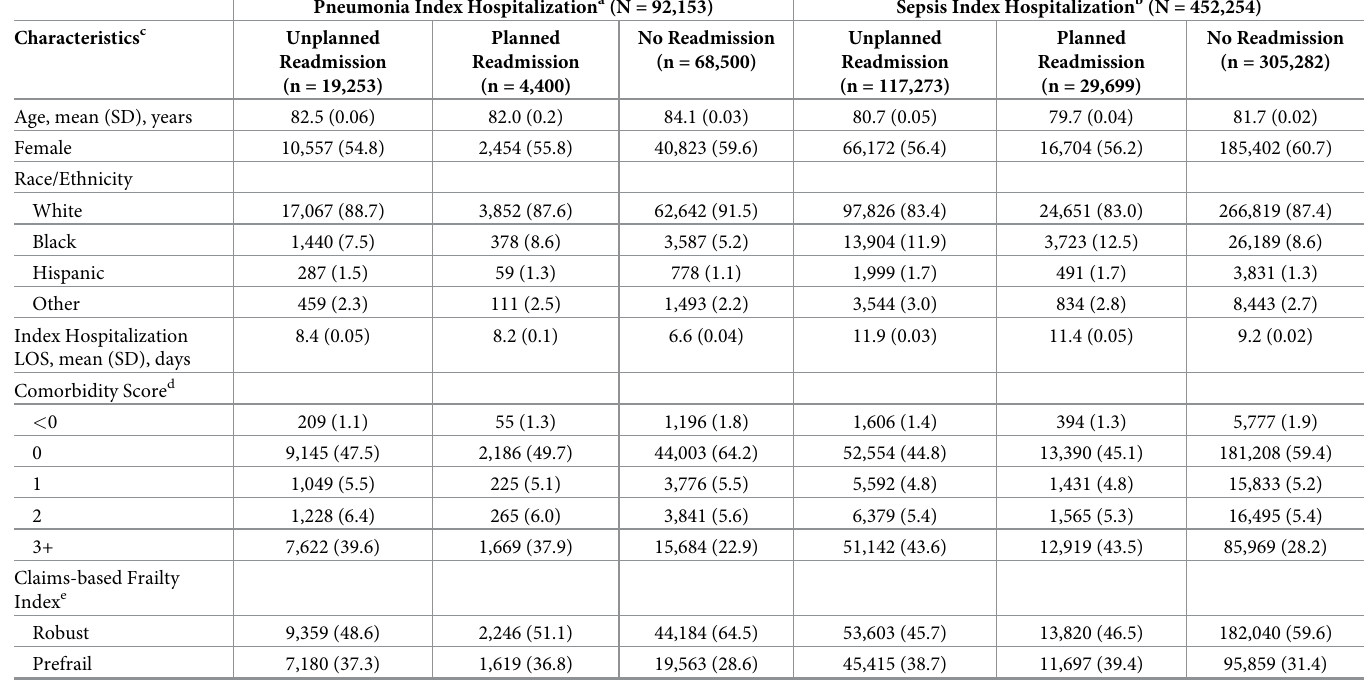
Table 1. Characteristics of older adults discharged to skilled nursing facilities following an index hospitalization for pneumonia or sepsis by 30-day hospital read- mission status, 2012–2015. Pneumonia Index Hospitalization a (N = 92,153) Sepsis Index Hospitalization b (N = 452,254) Characteristics